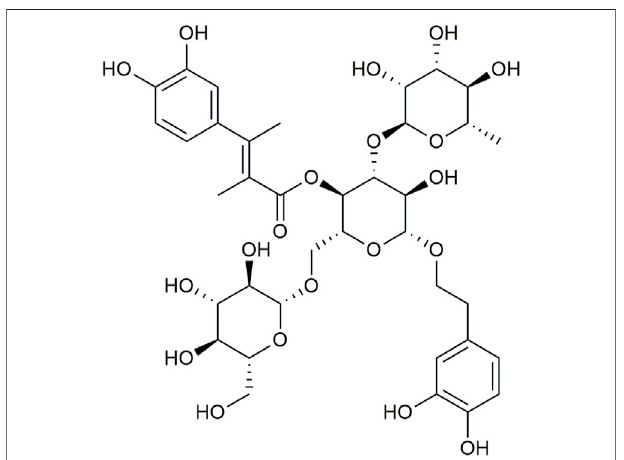
FIGURE 1 | Chemical structure of Echinacoside (ECH).